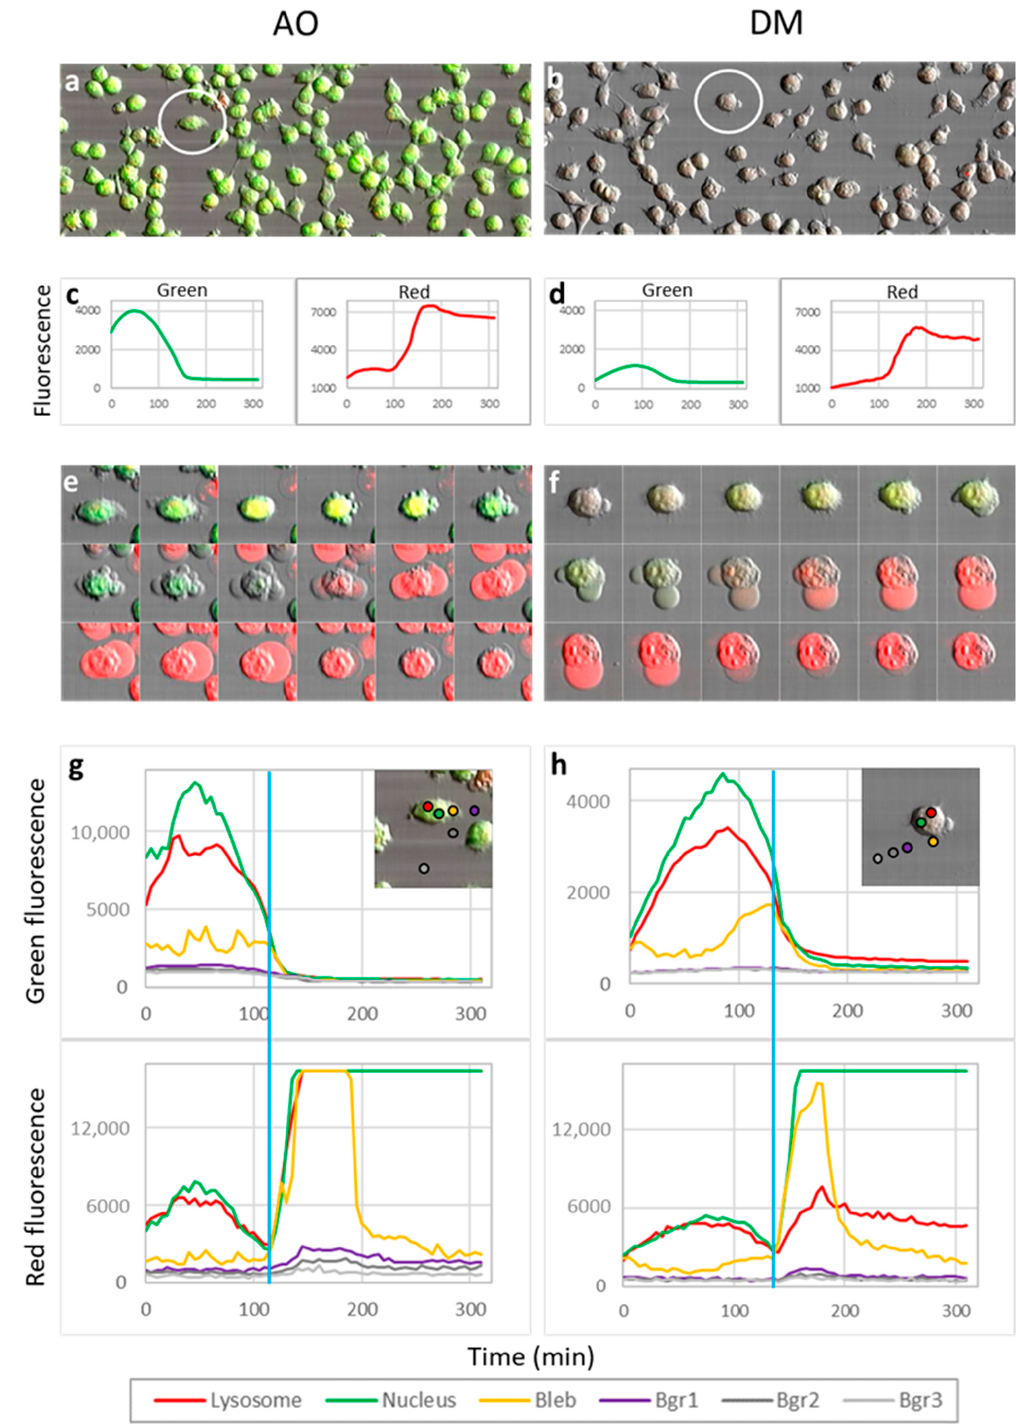
Figure 5. Kinetics of phototoxic cell death of HeLa cells labeled with AO or DM. A shockwave of DNA fragments leaving the nucleus can be recognized with the help of PI staining DNA red ( e , f panels). HeLa cells were pretreated with 2.5 µM AO (left panels: ( a , c , e , g )), or DM (right panels: ( b , d , f , h )), and cellular events were monitored in the presence of 7.5 µM propidium iodide. In 63 cycles at 5-min intervals, cells were illuminated by the repetitive scanning of the same area of cells. The corresponding snapshots of the cells were recorded with an iCys LSC imaging cytometry system. Panels ( c , d ) show overall kinetics of the green (ex. 488 nm, em. 530/20 nm, ( c ) on the left: AO and ( d ) on the right: DM) and red (ex. 561 nm, em. 580/20 nm) left, PI in the presence of AO and